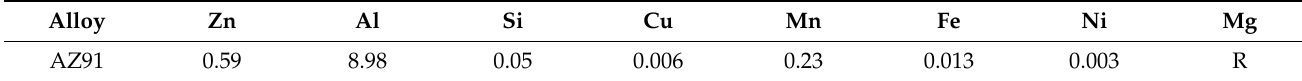
Table 1. Chemical composition of the investigated alloy